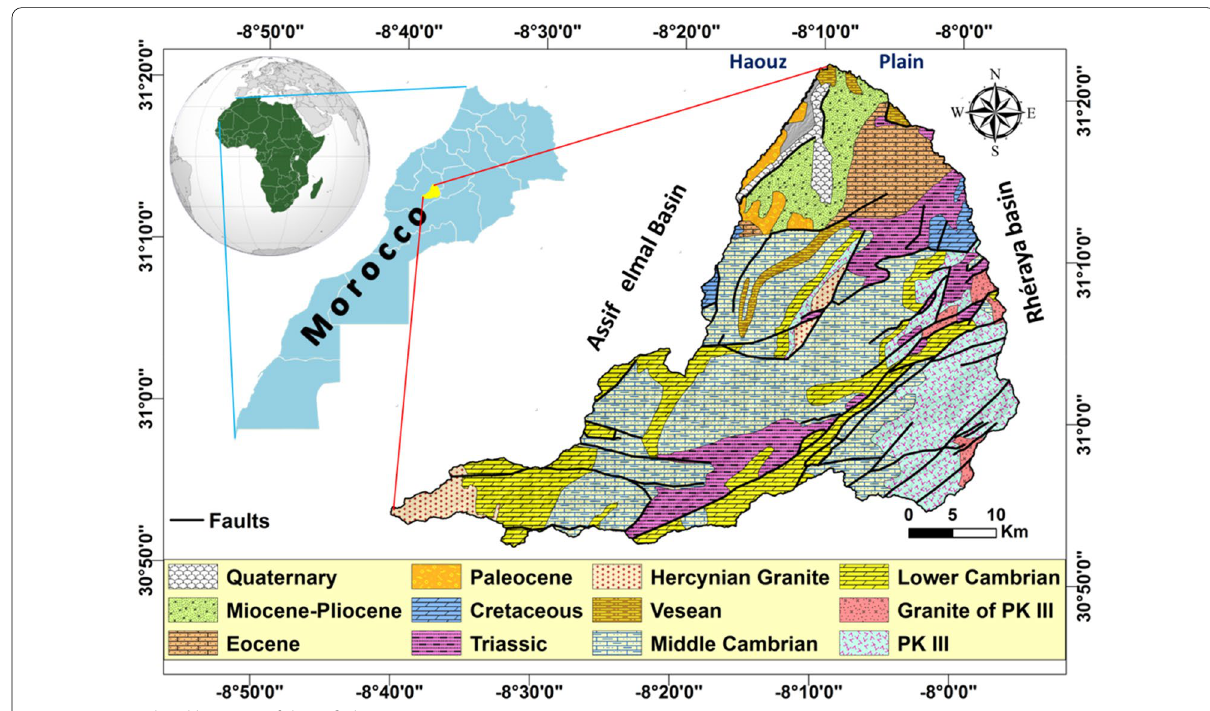
Fig. 1 Geographical location of the N’fis